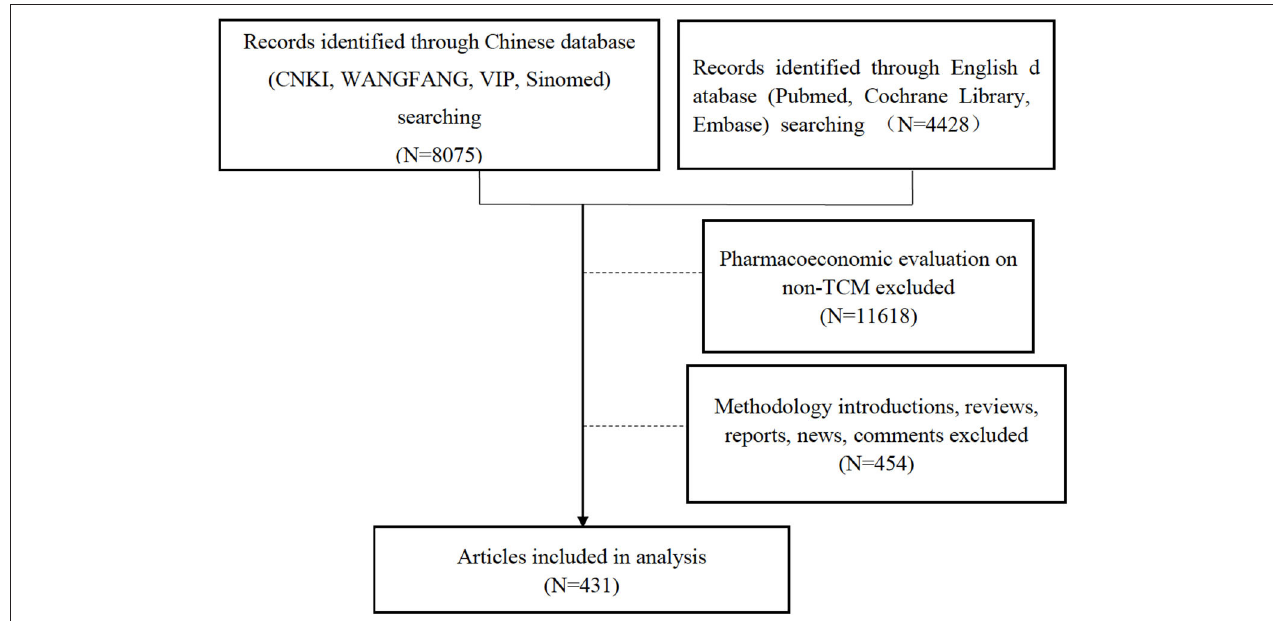
FIGURE 1 | Flow chart of study search and